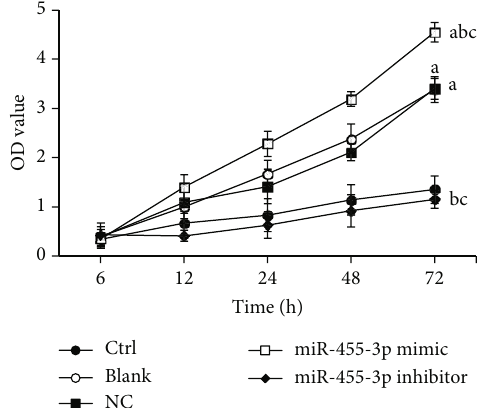
Figure 3: Comparison of proliferative activity of BMSCs. Note: A, B, C, and D meant P < 0 : 05 in comparison to the Ctrl, blank, NC, and mimic groups, respectively.